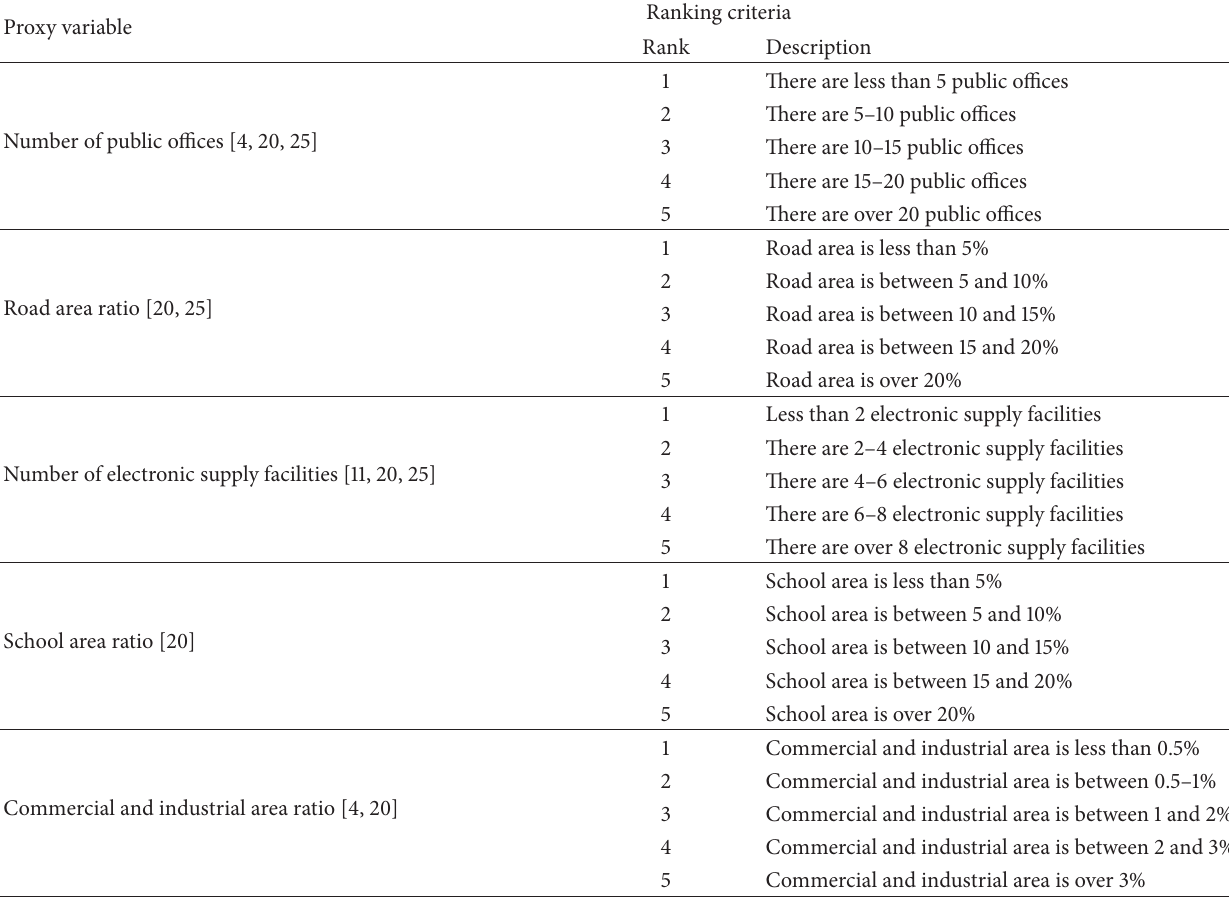
Table 5: Criteria for ranking of proxy variables of